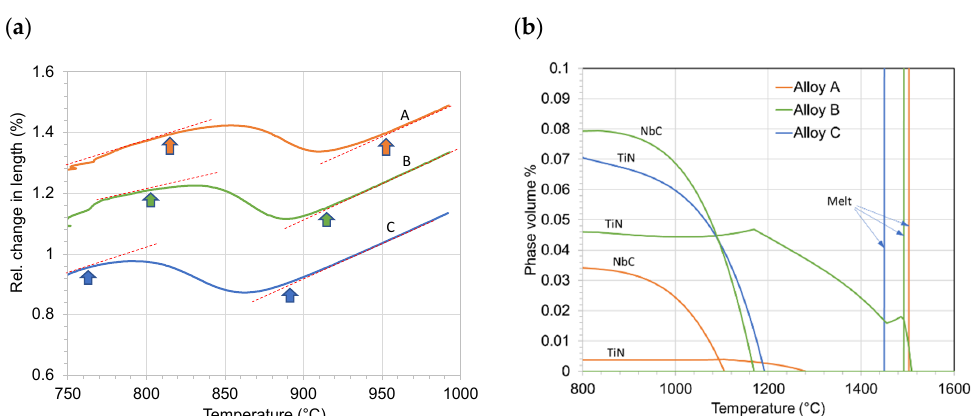
Figure 3. ( a ) Austenite formation kinetics in terms of relative change in length during heating of alloys A, B and C. The temperature on the curves marks the A c1 and A c3 temperatures. ( b ) Dependance of the precipitates volume % on the annealing temperature (predicted using ThermoCalc).